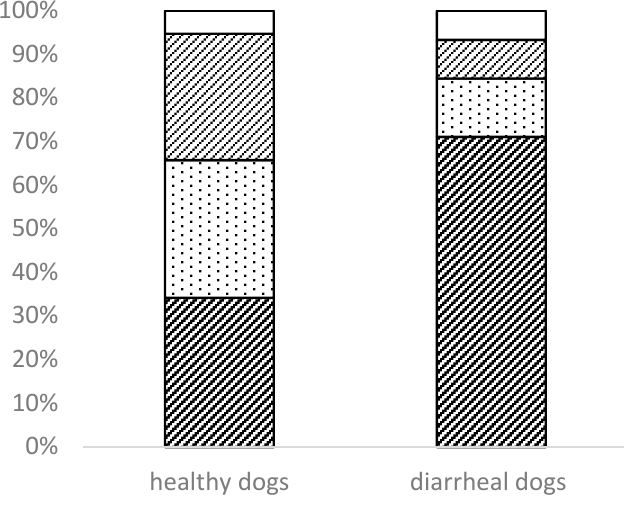
Figure 3. The ability of E. coli isolates to form biofilm.